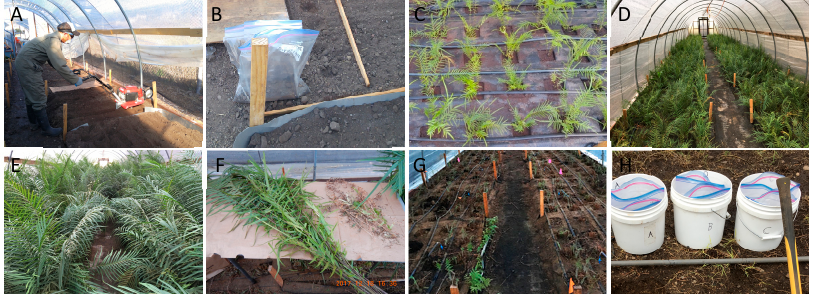
Figure 1. Field-scale phytoextraction of arsenic with Pteris vittata over one year in a Mediterranean climate (Richmond, CA, USA). ( A ) A season extension hoop house was constructed over the site, soil tilled, soil treatments mixed in, and ( B ) soil sampled before ( C ) ferns were planted. ( D ) Ferns were approximately 30–50 cm high at 26 weeks and ( E ) up to 2 m tall at harvest (58 weeks). ( F ) Randomly selected ferns were cut for analysis and senesced fronds separated from living fronds. ( G ) Field was fully harvested and rhizomes removed before ( H ) final soil sampling. Full details are available in Matzen et al.,